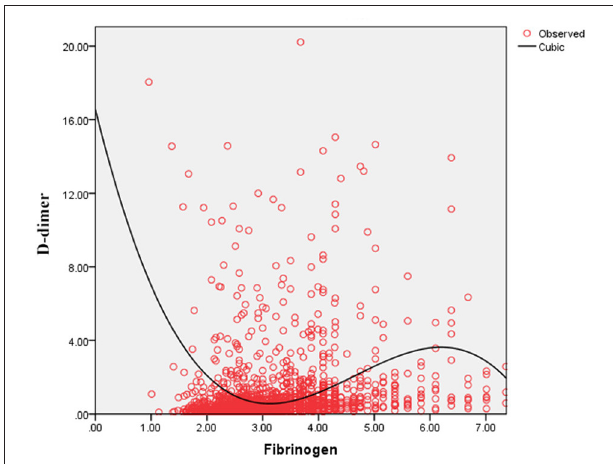
FIGURE 4 | Fitted curves of the fibrinogen level and D-dimer concentration in patients with COVID-19.